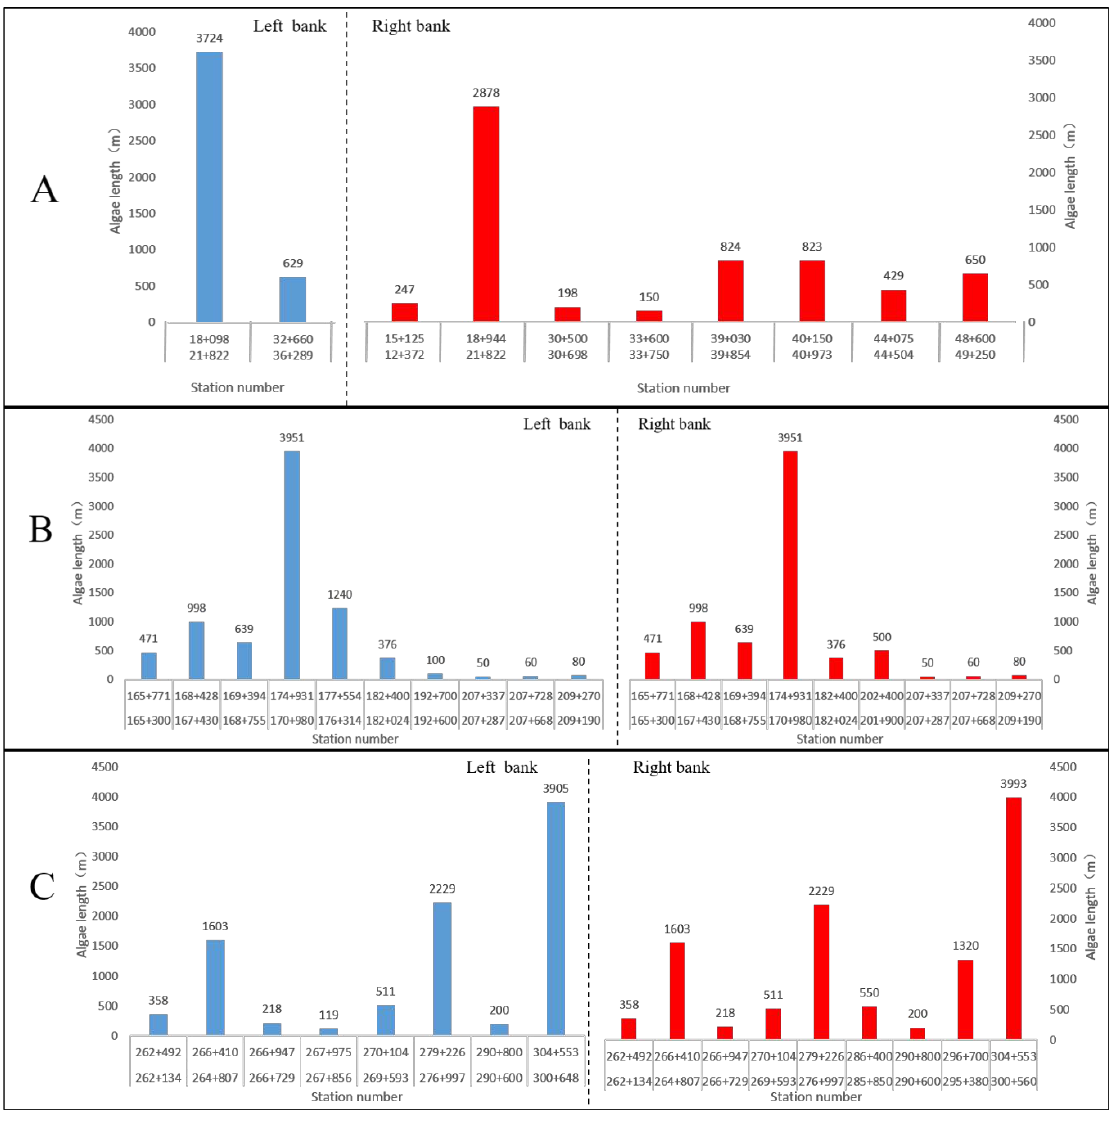
Figure 8. Lengths of algae growth zones.